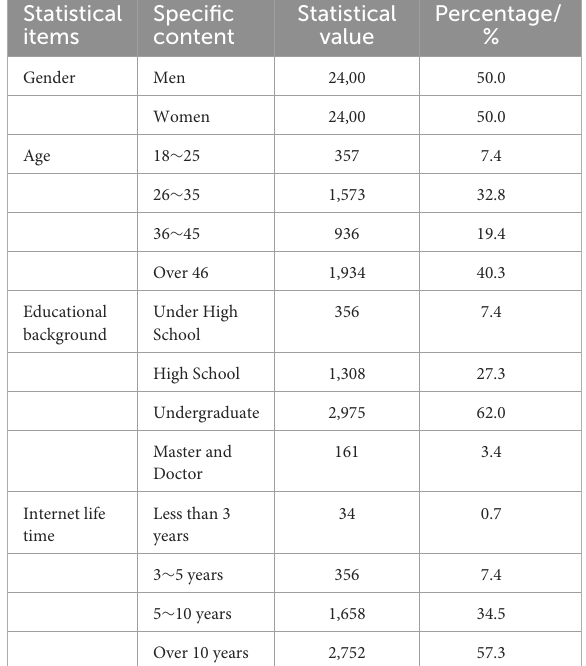
TABLE 1 Statistical table of basic information on effective